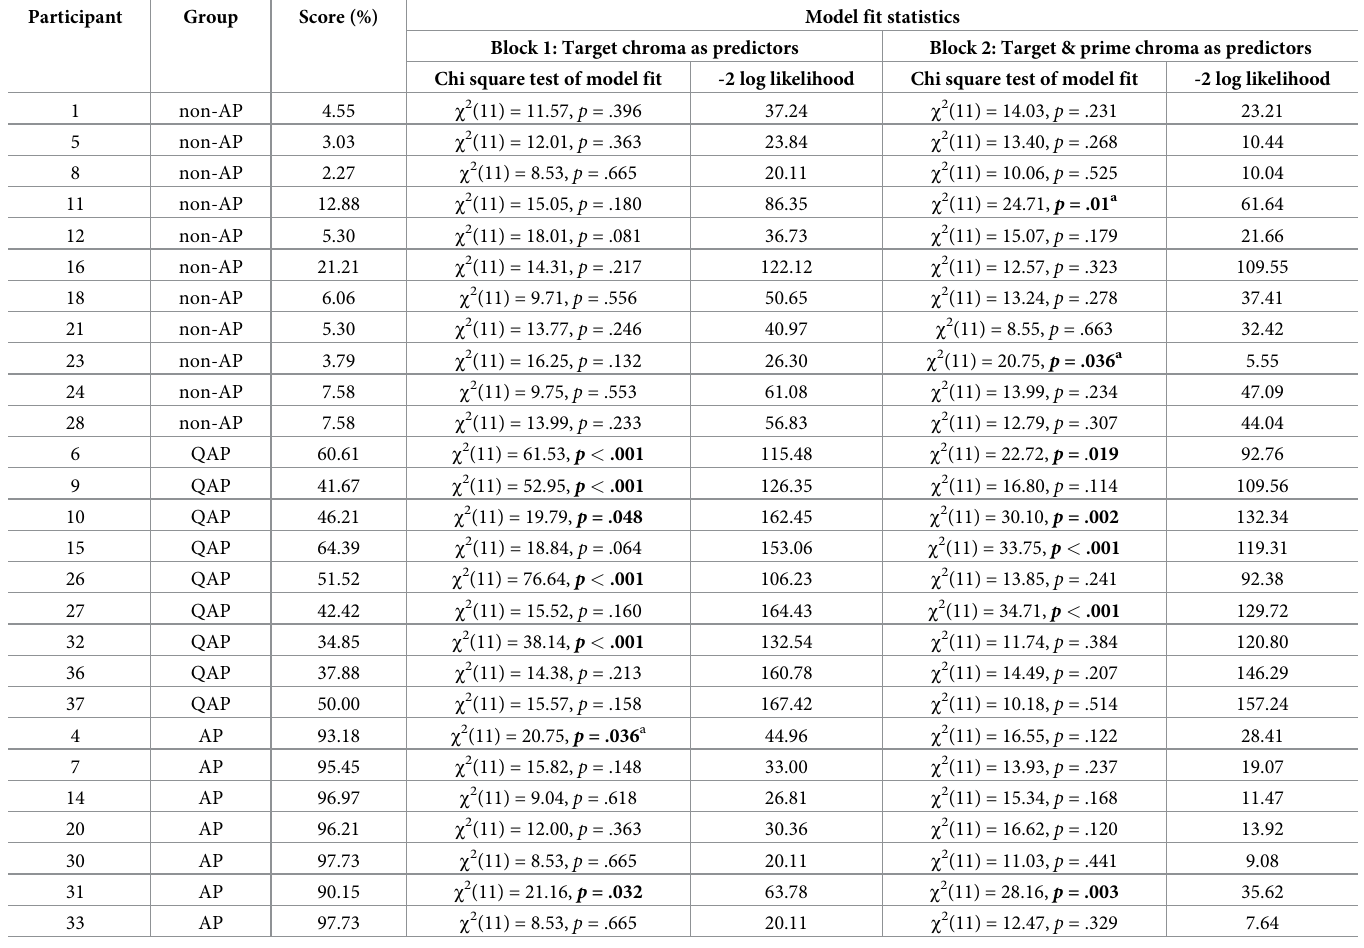
Table 5. Model fit statistics for individual logistic regressions for